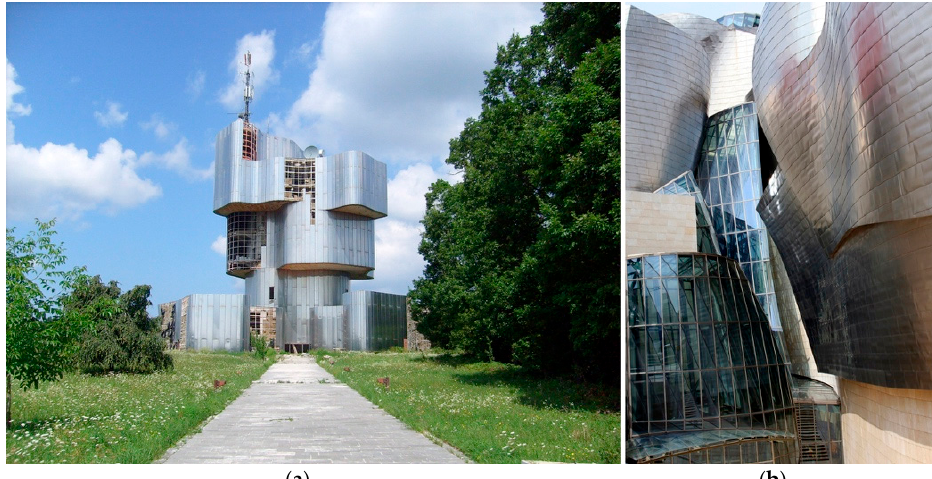
Figure 8. Petrova Gora Monument, built in 1981. ( a ) The state of decay, as of 2010; ( b ) the spatial composition of the monument has been seen as a predecessor to the hybridity of architecture and sculpture, as the example of the Guggenheim Museum (1997) in Bilbao shows. Photos: ( a ): Sandor Bordas, Creative Commons Attribution-Share Alike 3.0 Unported, https://creativecommons.org/ licenses/by-sa/3.0/deed.en; ( b ): E. Goergen, Creative Commons Attribution-Share Alike 3.0